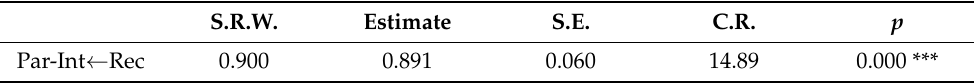
Table 3. Regression weights.